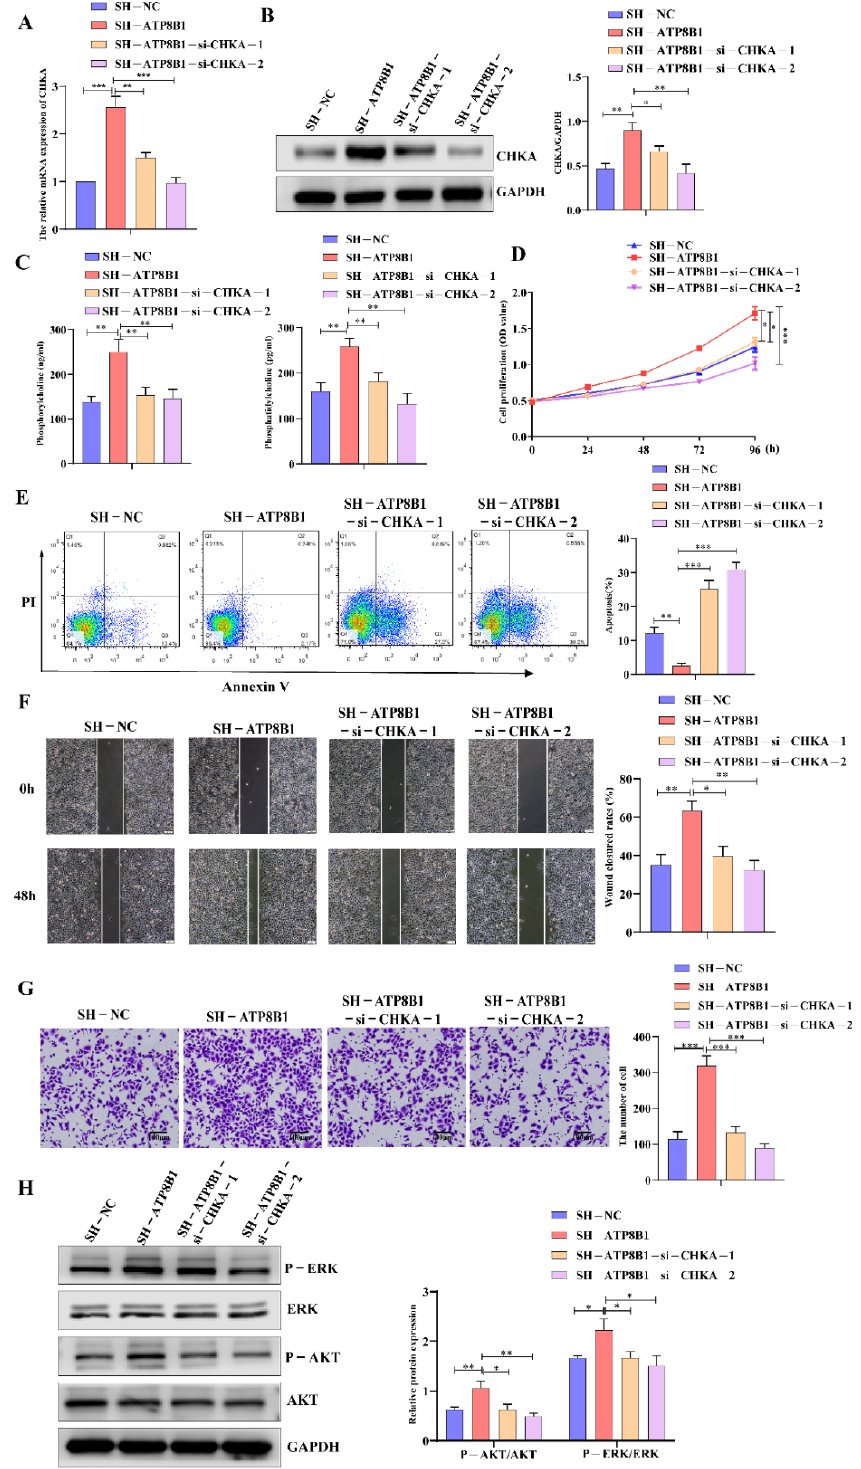
Figure 4. Interfering with CHKA expression in H520 SH － ATP8B1 inhibited tumor progression. ( A ) Ex- pression of CHKA in different cells at the mRNA level. All the RT-qPCR results shown for H520 SH － ATP8B1 and H520 SH － ATP8B1-si － CHKA were relative mRNA expression values compared to H520 SH － NC for normalization. ( B ) Expression of CHKA in different cells at the protein level. ( C ) The ELISA results of phosphorylcholine and phosphatidylcholine. ( D ) Cell proliferation results. ( E ) Cell apop- tosis results. ( F ) Representative images of the wound healing assays. ( G ) Representative images of